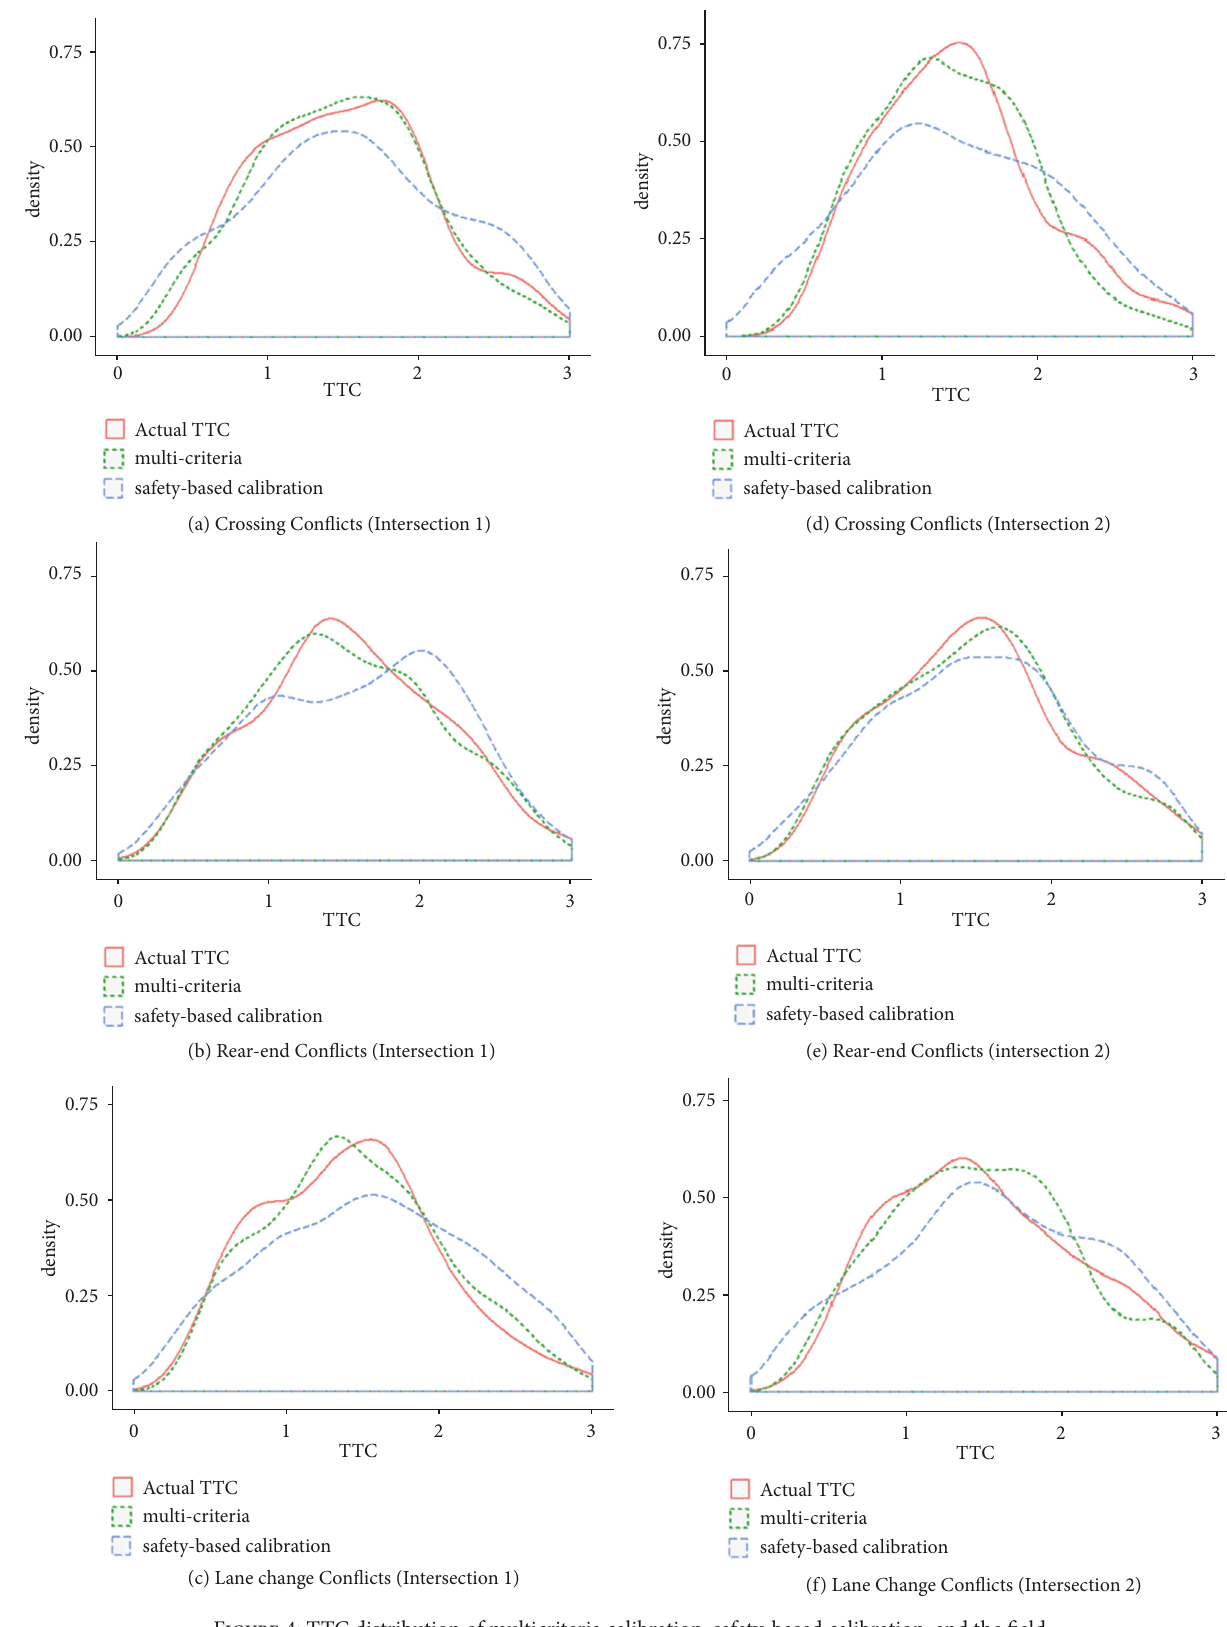
Figure 4: TTC distribution of multicriteria calibration, safety-based calibration, and the